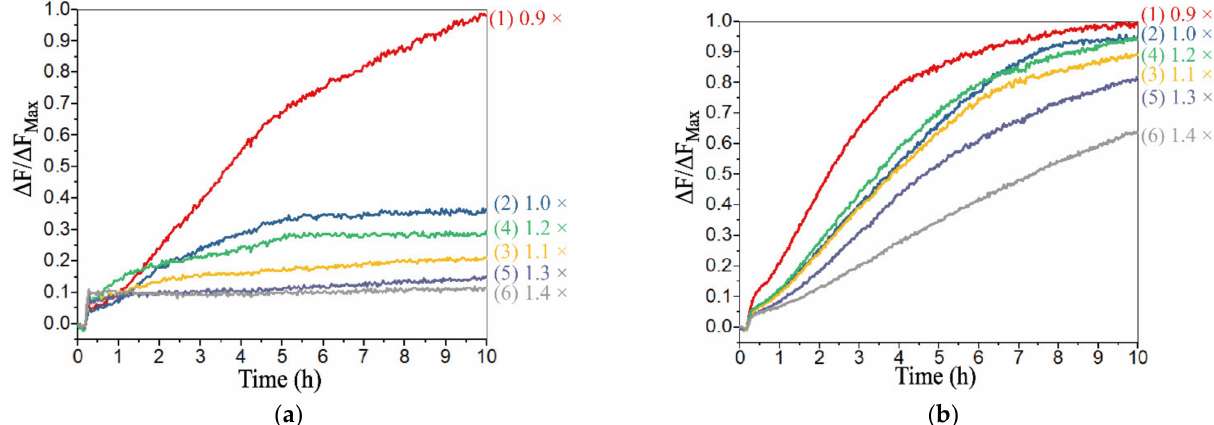
Figure 8. Fluorescence analysis for different concentrations of DNA strand D-F, which are 0.9 × , 1.0 × , 1.1 × , 1.2 × , 1.3 × and 1.4 × 0.5 µ M, respectively. The fluorescence intensities are recorded every 10 min. ( a ) DNA strand D1 R is added to the voter. ( b ) DNA strands D-IN and D2 R are added to the voter.